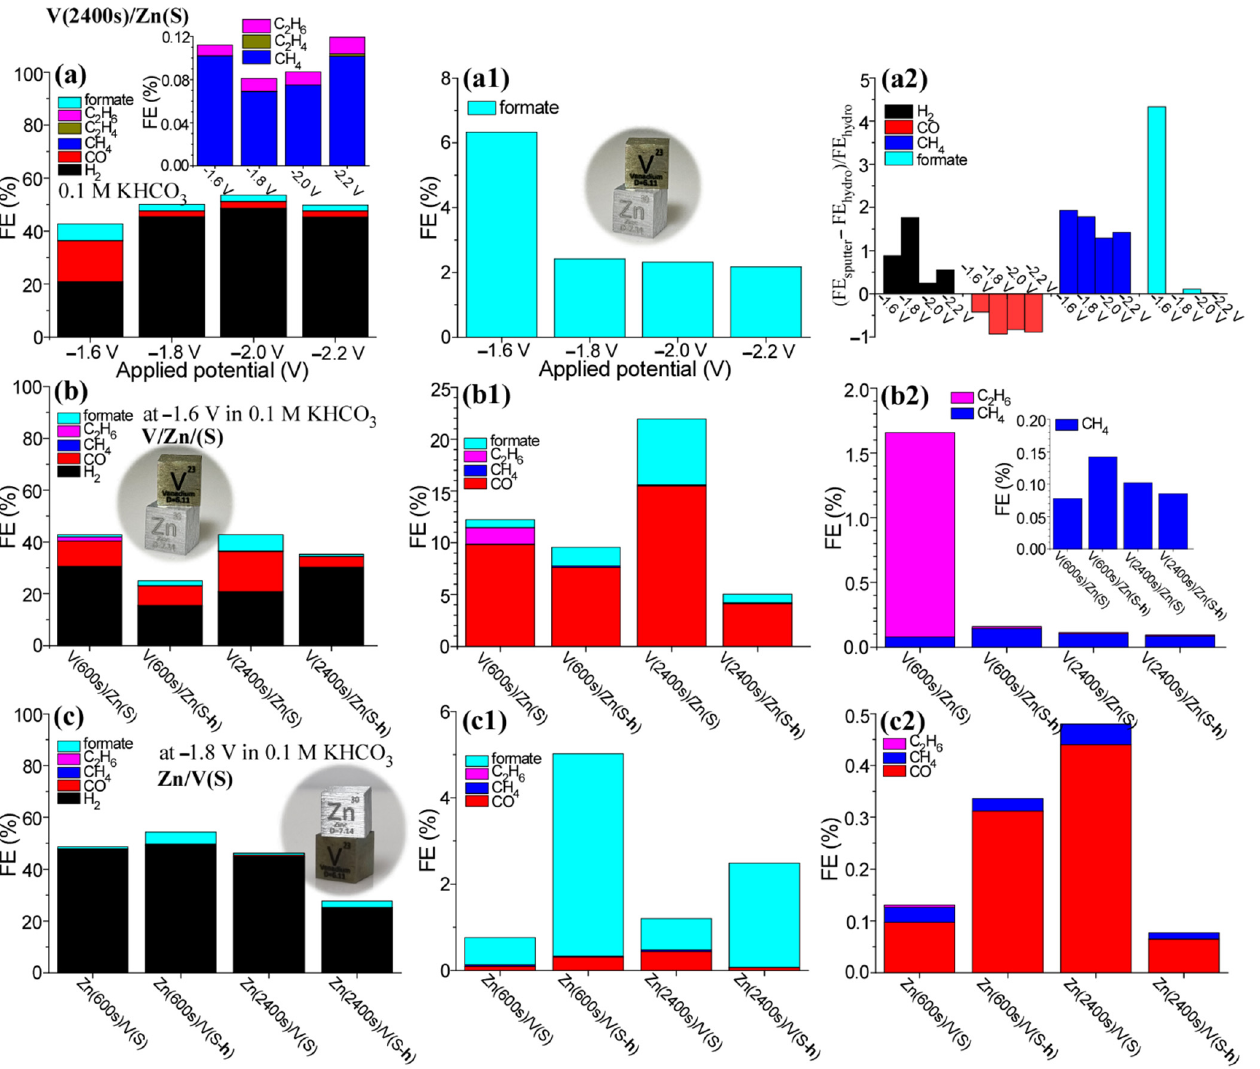
Figure 4. FEs of gas and liquid products over V/Zn(S) electrode at various applied potentials of − 1.6 V, − 1.8 V, − 2.0 V, and − 2.2 V (vs. Ag/AgCl) in 0.1 M KHCO 3 electrolyte ( a , a1 ). (FE V/Zn(S) - FE V/Zn(H) )/FE V/Zn(H) ratios for H 2 , CO, CH 4 , and formate productions ( a2 ). FEs of gas and liquid products over V(600 s)/Zn(S), V(600 s)/Zn(S-h), V(2400 s)/Zn(S), V(2400 s)/Zn(S-h) at − 1.6 V in 0.1 M KHCO 3 electrolyte, and over V(2400 s)/Zn(S) at − 1.8 V ( b , b1 , b2 ). FEs of gas and liquid products over Zn(600 s)/V(S), Zn(600 s)/V(S-h), Zn(2400 s)/V(S), Zn(2400 s)/V(S-h) at − 1.8 V in 0.1 M KHCO 3 electrolyte ( c , c1 , c2 ).